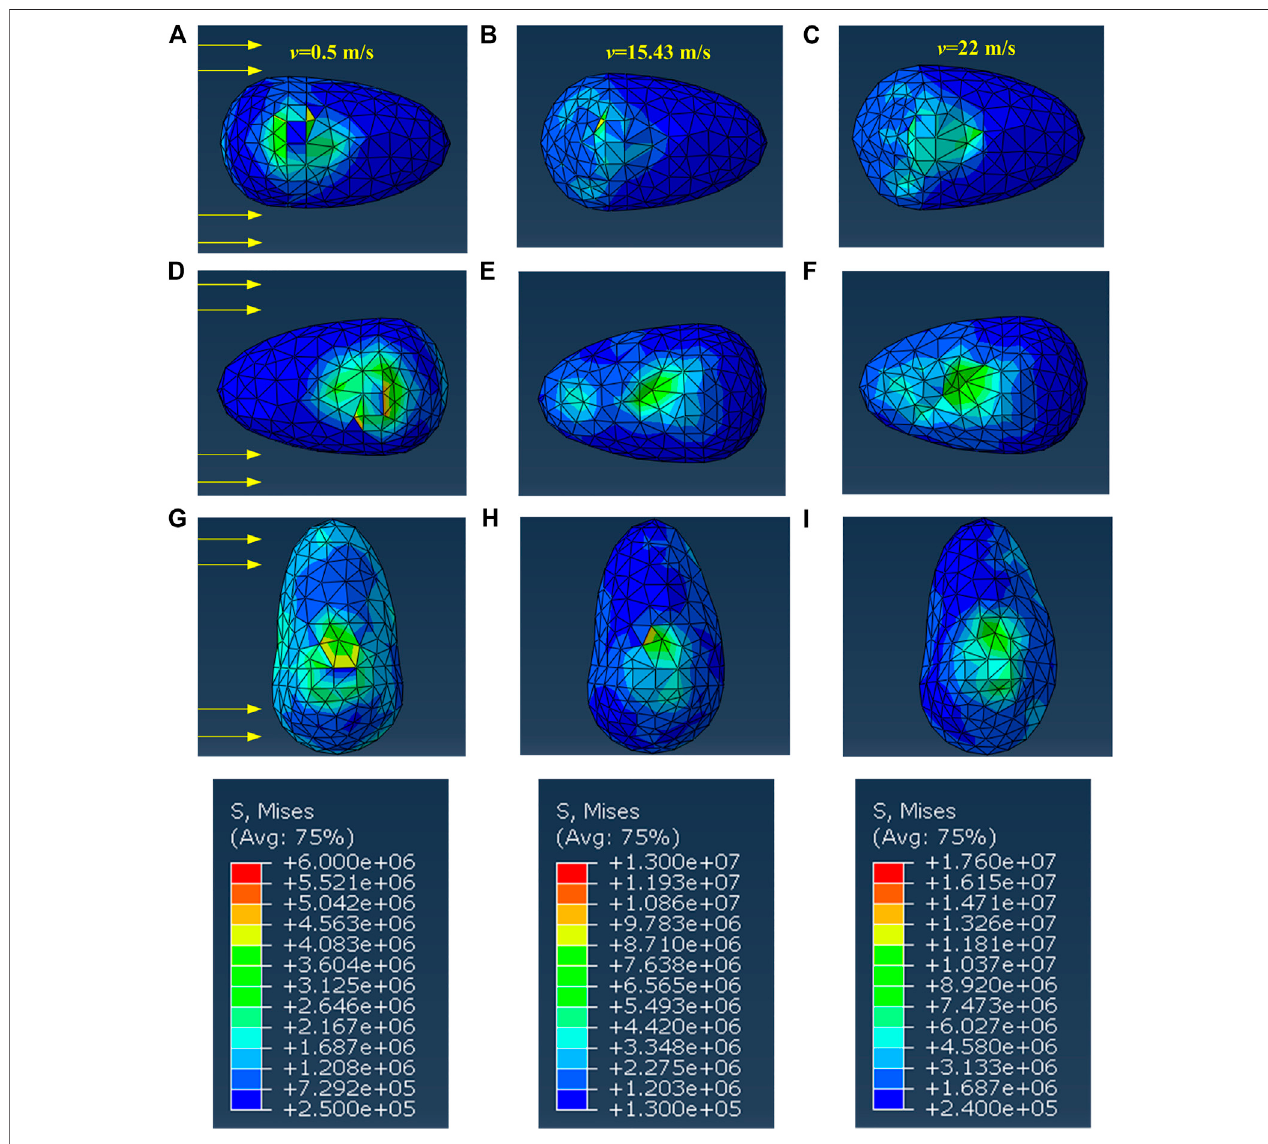
FIGURE 2 | The cloud diagram of the pedal ’ s stress with (A – C) posture 1 (D – F) posture 2 (G – I) posture 3.